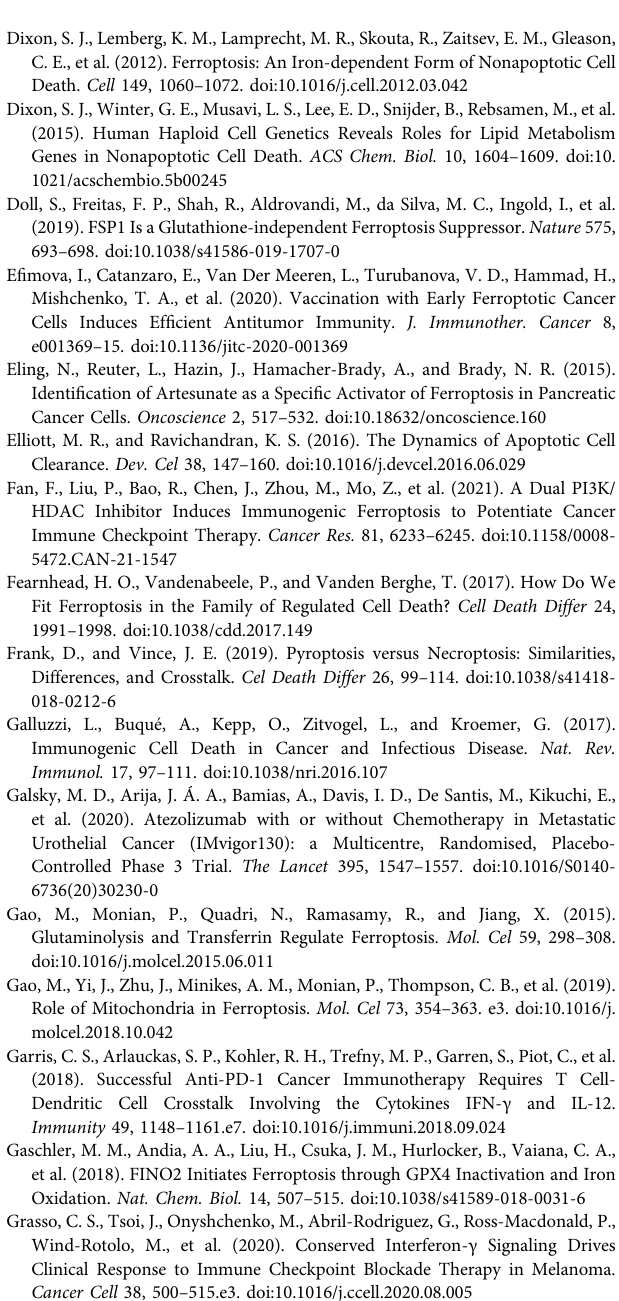
Figure 1 was adapted from “ Blockade of CTLA-4 or PD-1 Signaling in Tumor ” by BioRender.com (2021), retrieved from